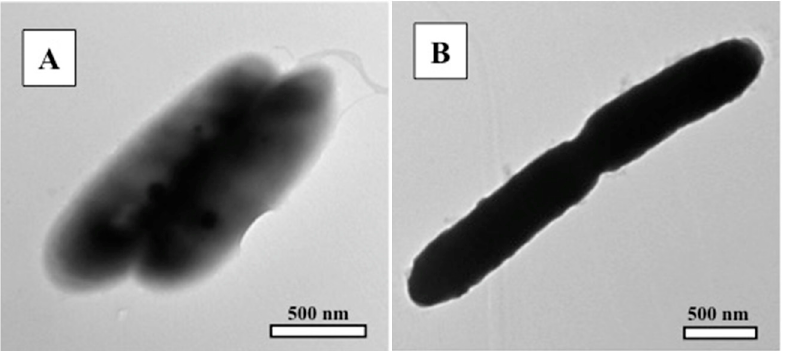
Figure 5. Whole mount TEM micrographs of C. metallidurans reacted with 500 µM Pt(IV) for: ( A ) 1 min, and ( B ) 1 day. As incubation time increased, Pt staining became more pronounced. Colloidal platinum was not observed at any exposure time.